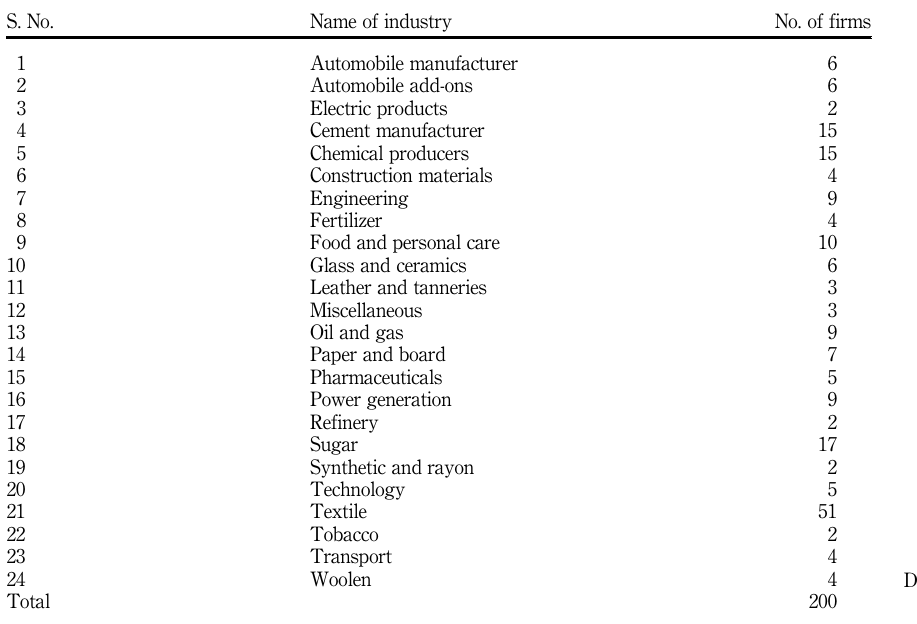
Table I. Distribution of firms across